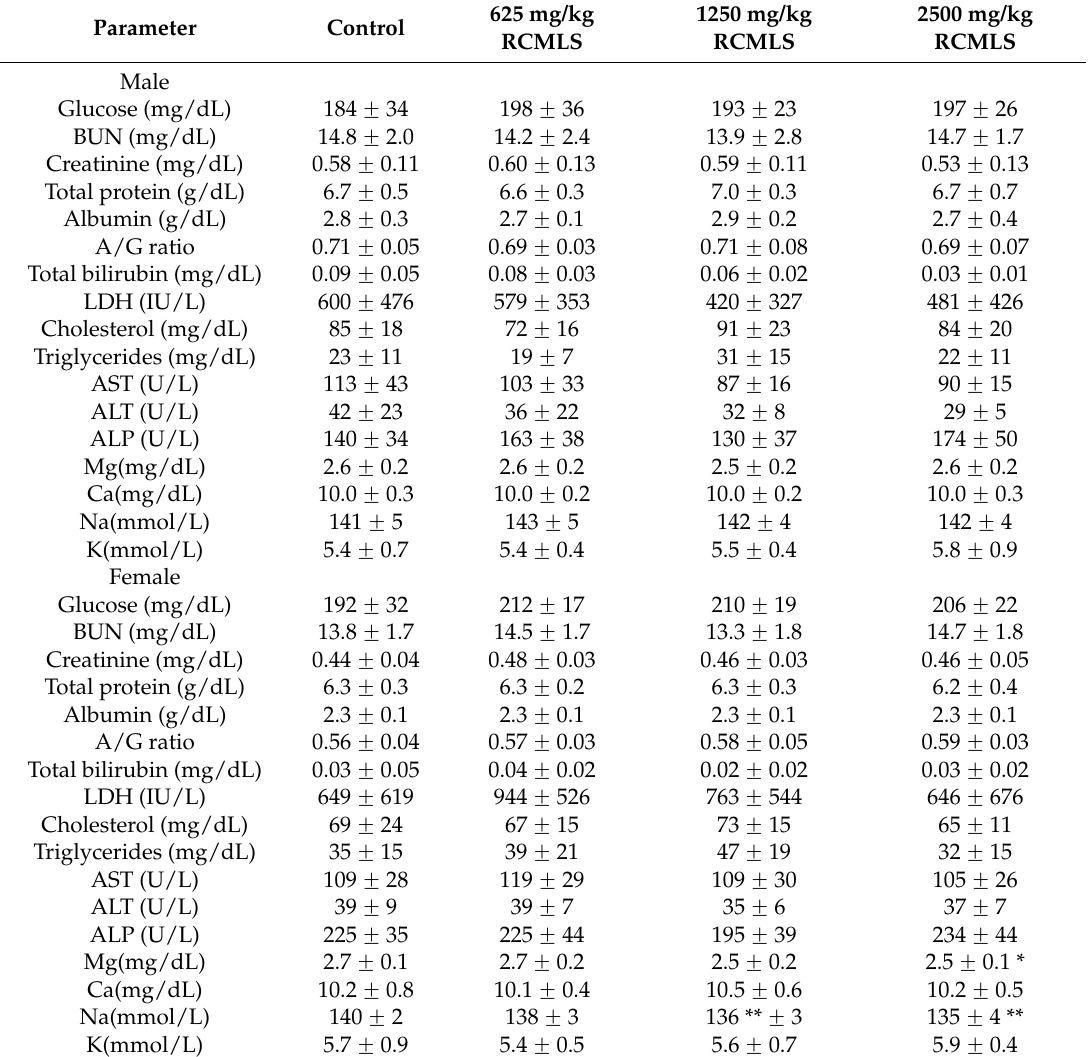
Table 8. Serum biochemistry in 13 weeks repeated oral dose toxicity study of the leaves and stems of Rubus coreanus